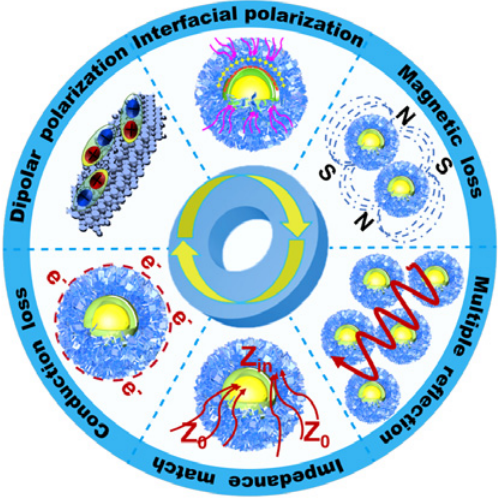
Fig. 9 Proposed electromagnetic wave absorption mechanisms of SiO 2 @Ti 3 C 2 T x @CoNi